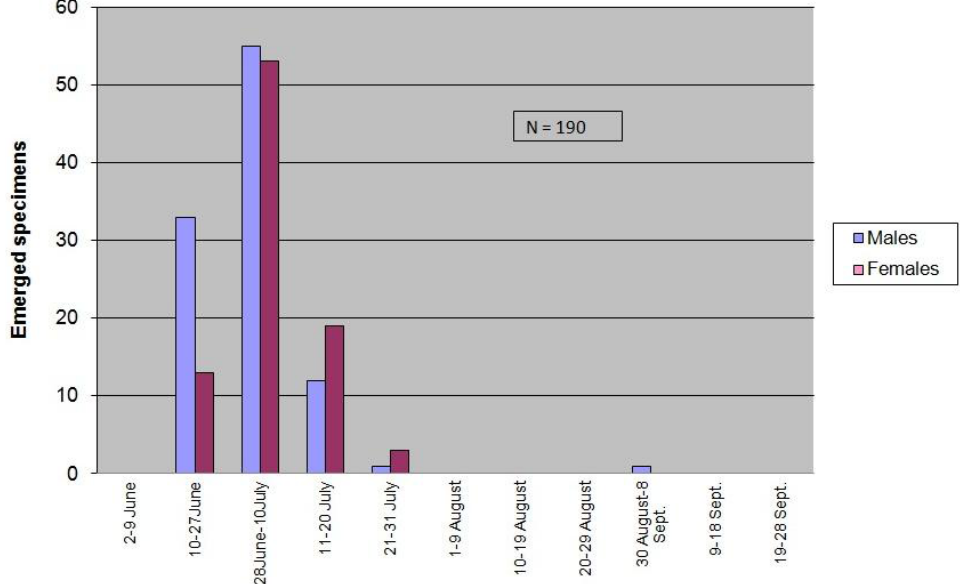
Figure 4. X. chinensis 2017 adult seasonality at Barberà del Vallès (Barcelona, Catalonia).